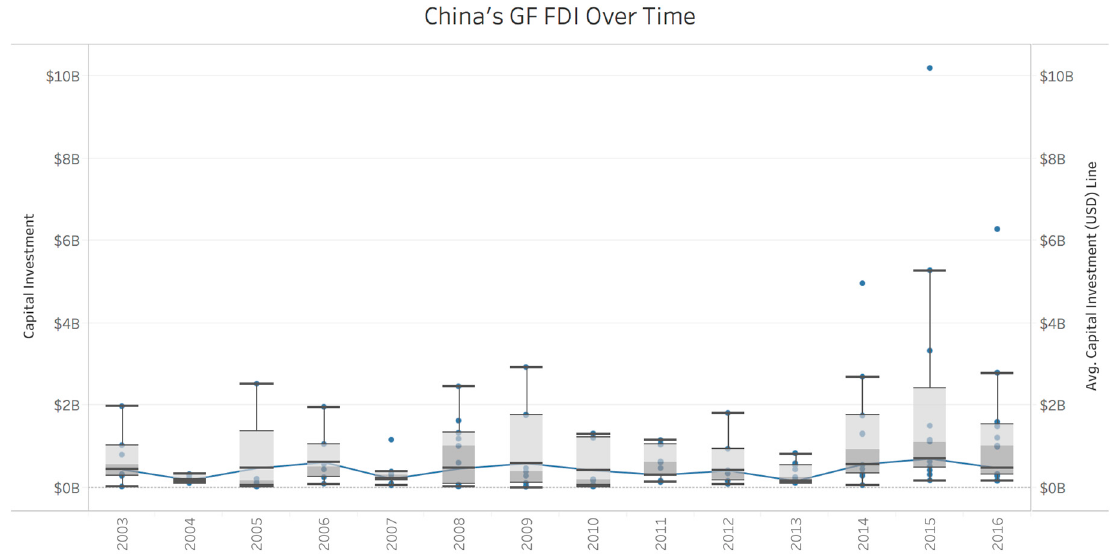
Figure 10. Box and whisker plot of China’s GF FDI in energy sectors. The left axis shows the capital investment for each year. The average investment (right axis) is shown as a blue line in the box plot. The median value of the investment is around $1 B with variations in the distributions; the widest distribution was in 2015.